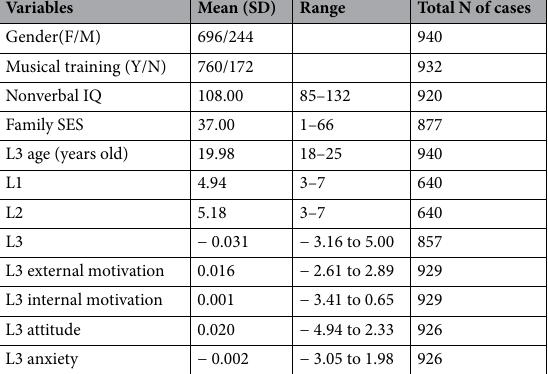
Table 2. Demographic information and phenotype scores of participants. L1 and L2 proficiency were represented by the composite grades of the Chinese and English subjects in the HKDSE exam. Gender (F/M) = female/male. Music training (Y/N) = have/have not received at least 1 year of musical training.